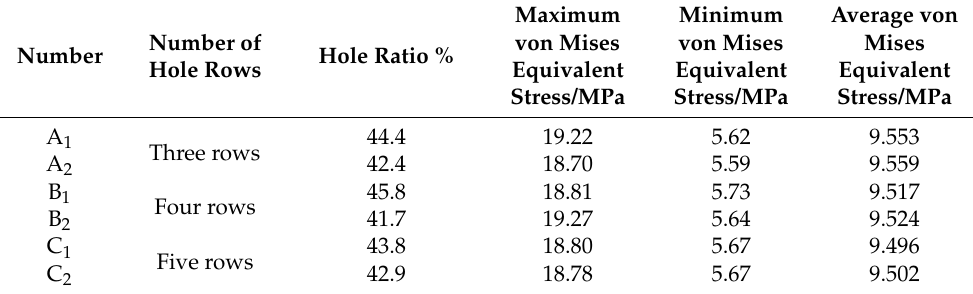
Figure 13. ( a ) Deformation contour plot; ( b ) von Mises equivalent stress contour plot. Table 6. Simulation results of the von Mises equivalent